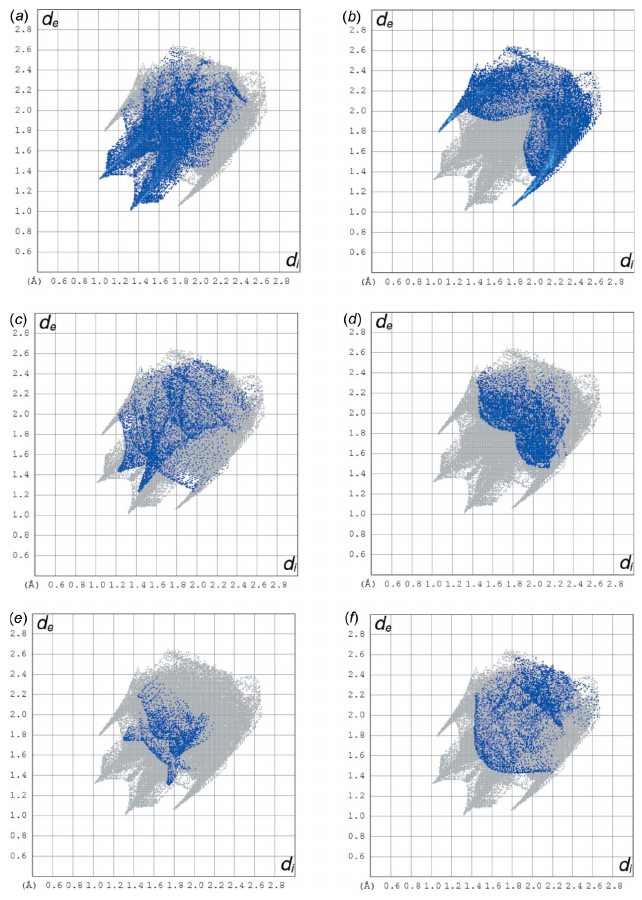
Figure 5 Two-dimensional fingerprint plots with a d norm view of the ( a ) O (cid:3)(cid:3)(cid:3) H/ H (cid:3)(cid:3)(cid:3) O (20.2%), ( b ) Br (cid:3)(cid:3)(cid:3) H/H (cid:3)(cid:3)(cid:3) Br (21.7%), ( c ) F (cid:3)(cid:3)(cid:3) H/H (cid:3)(cid:3)(cid:3) F (7.4%), ( d ) C (cid:3)(cid:3)(cid:3) H/H (cid:3)(cid:3)(cid:3) C (9.7%), ( e ) N (cid:3)(cid:3)(cid:3) H/H (cid:3)(cid:3)(cid:3) N (3.3%) and ( f ) H (cid:3)(cid:3)(cid:3) H (6.0%) contacts in the title